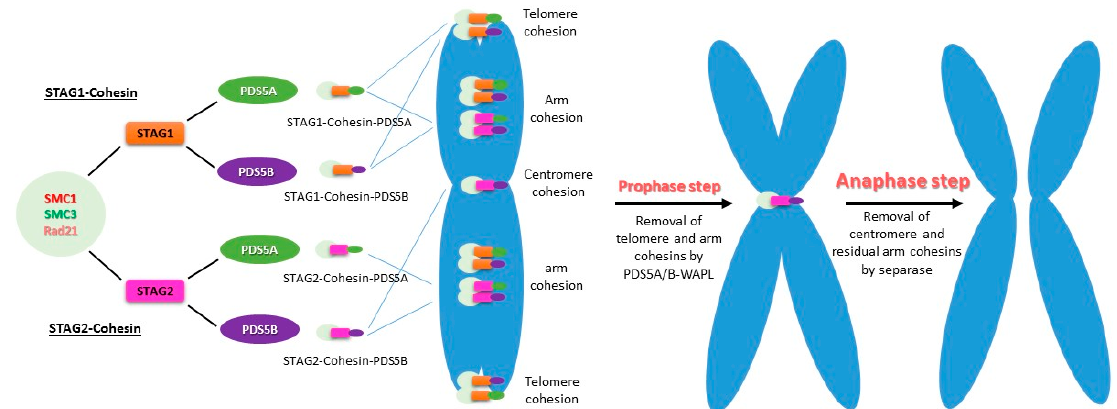
Figure 3. Stepwise cohesin removal from chromosomes in vertebrates. PDS5A and PDS5B bind to STAG1-cohesin or STAG2-cohesin, forming four different types of complexes, to execute their functions in the establishment, maintenance, and resolution of sister chromatid cohesion at S, G2, and M phases, respectively. All four PDS5-associated cohesins contribute to the chromosomal arm cohesion. The telomere regions contain PDS5A- and PDS5B-associated STAG1-cohesin specifically, whereas the centromeres have STAG2-cohesin-PDS5B only. At prophase, WAPL displaces phosphorylated sororin and binds to PDS5 to release the cohesins on the arm and telomere. At the transition of metaphase and anaphase, activated separase cleaves cohesin subunit Rad21, resulting in cohesin on the centromere and residual cohesin on the arm being released. Therefore, the sister chromatids are free to be segregated into two daughter cells.